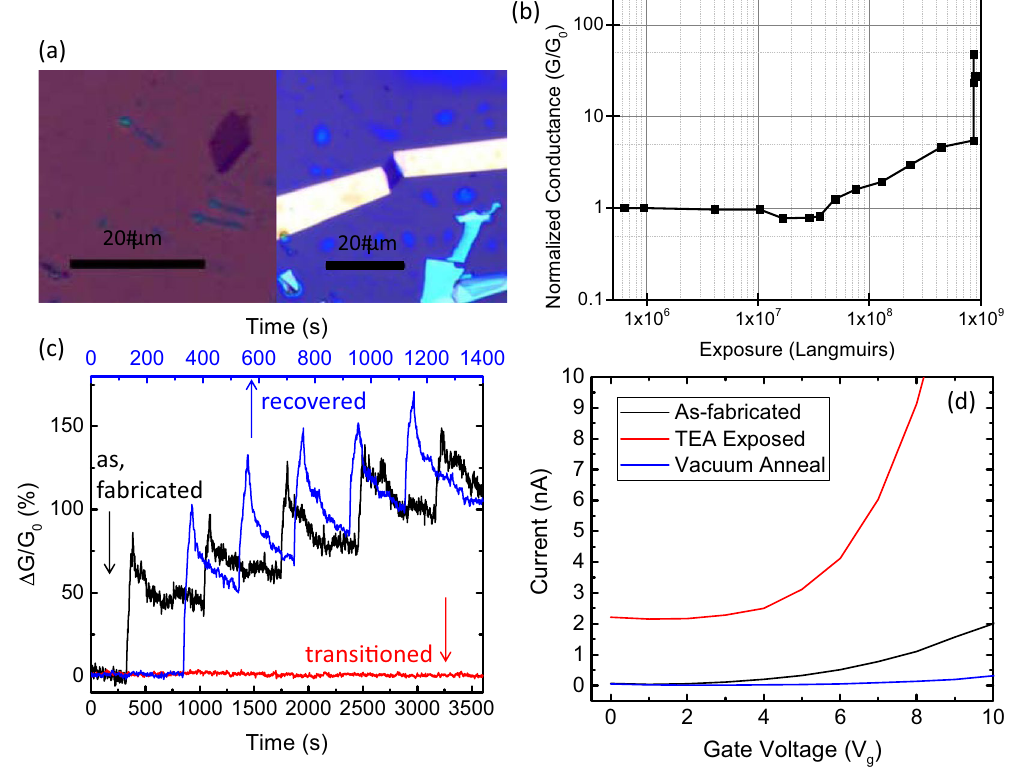
Figure 2. ( a ) Optical image of a monolayer MoSe 2 flake (left) and a MoSe 2 FET device fabricated from that flake (right). ( b ) Normalized MoSe 2 device conductance as a function of chemical vapor exposure for a typical device. The device stopped responding to analyte vapor at the point where the conductivity is observed to abruptly rise, about 8 × 10 8 Langmuirs. Annealing resulted in the recovery of the original conductance and sensor response. ( c ) Response to a pulsed sequence of 0.04% P 0 BuAm vapor. The black line shows the sensor response of the as-fabricated device to a series of pulses (60 s on, 645 s off), and the red line shows an unresponsive sensor corresponding to 9 × 10 8 Langmuirs in ( b ) and with the same series of pulses. Both of these traces go with the bottom x-axis. The blue line (goes with the top x-axis) shows the recovered response of the device to a series of pulses (30 s on, 160 s off) after annealing at 400 °C in vacuum for 2 hours. ( d ) Current vs. back gate voltage taken at 1 V for before exposure, after exposure, and after annealing the